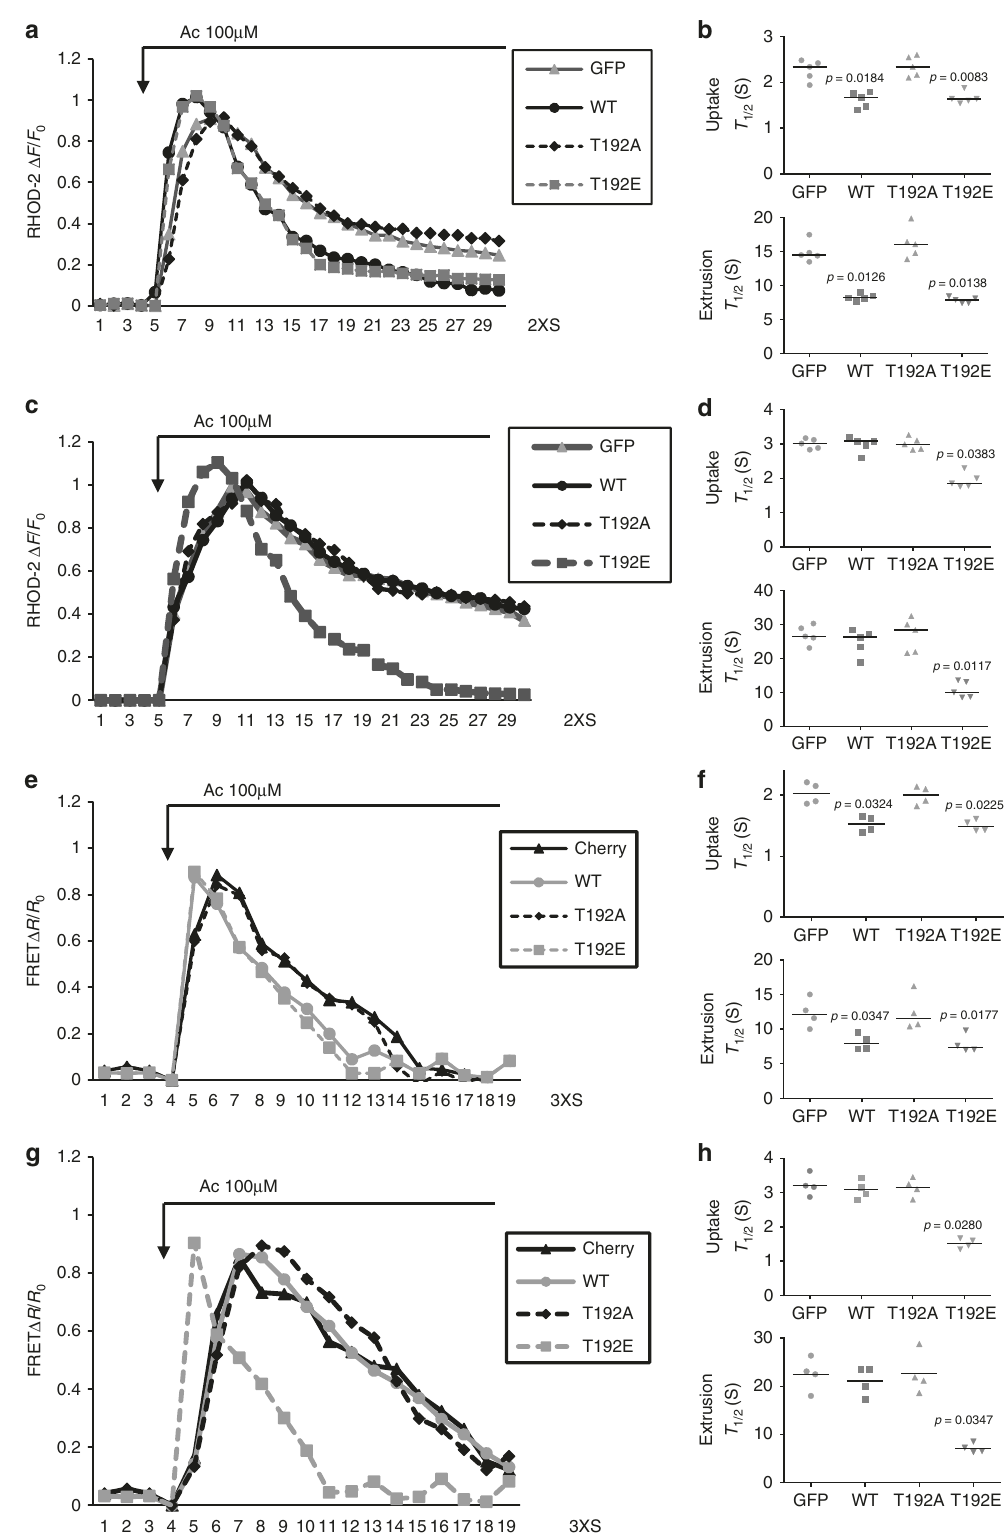
Fig. 4 The effect of phospho-LETM1 at Thr192 on mitochondrial calcium transport in primary cortical neurons. a Representative fl uorescence traces of mitochondrial Ca 2+ imaging in neurons from PINK1 WT infected with adenovirus GFP, LETM1-WT, T192A, and T192E stimulated by Ac. b Quanti fi cation of the rate of calcium transport release activity in a measured by T 1/2 . n = 5. c Representative fl uorescence traces of mitochondrial Ca 2+ imaging in neurons from PINK1 KO infected with adenovirus GFP, LETM1-WT, T192A, and T192E stimulated by Ac. d Quanti fi cation of the rate of calcium transport release activity in c measured by T 1/2 . n = 5. e Representative traces of mitochondrial Ca 2+ imaging in neurons infected with lenti-4mTG-TN-XXL from PINK1